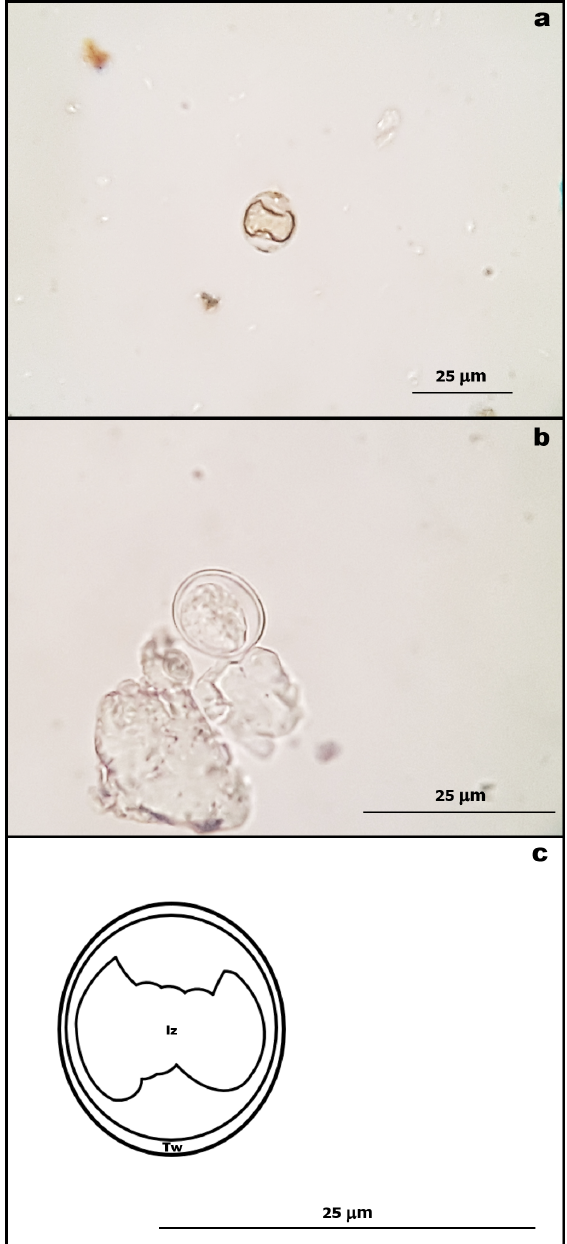
Figure 2. Eucoccidiorida subspherical oocysts recovered in coprolite assigned to Carnivora mammal from the Milton Almeida Outcrop, Touro Passo Formation (Upper Pleistocene), Municipality of Uruguaiana, Western region of State of Rio Grande do Sul, Southern Brazil (400 X magnification). a-b. Photomicrographs; c. Representative drawing. apparently at the beginning of